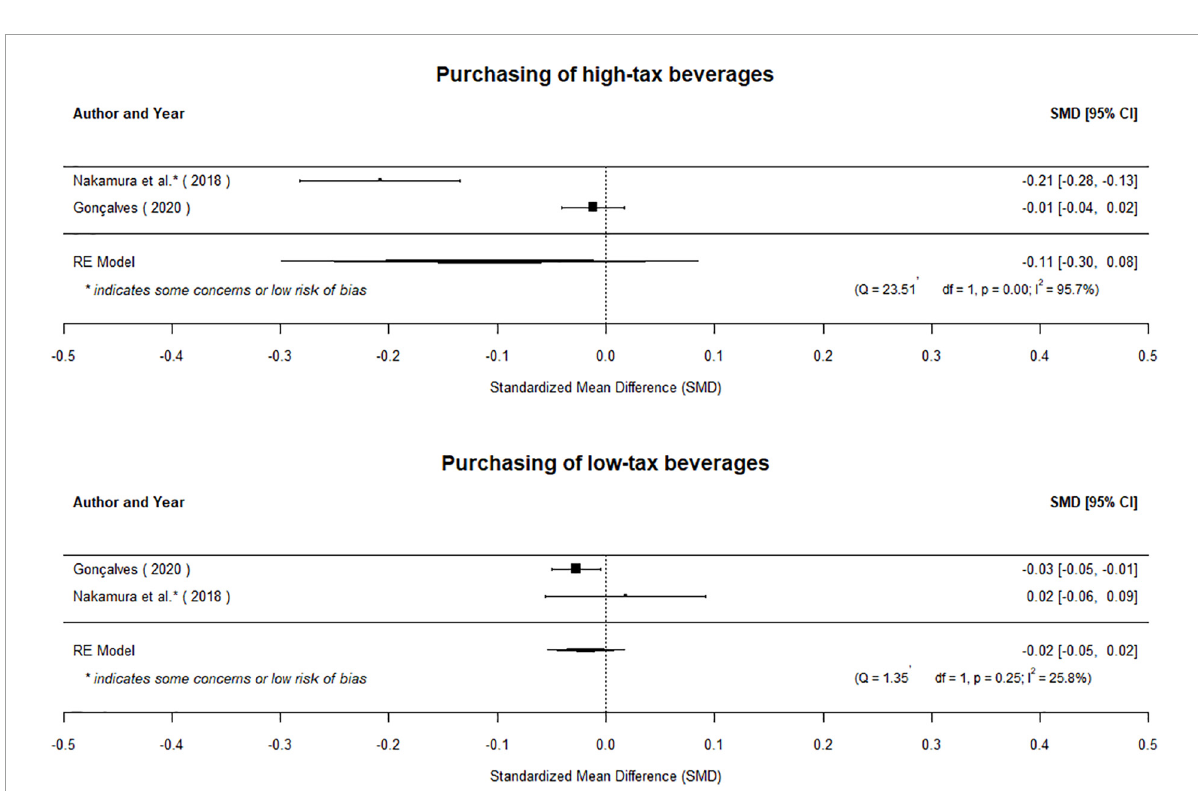
FIGURE7 The evidence base is too limited to draw conclusions about the effects of high-tax and low-tax beverages on